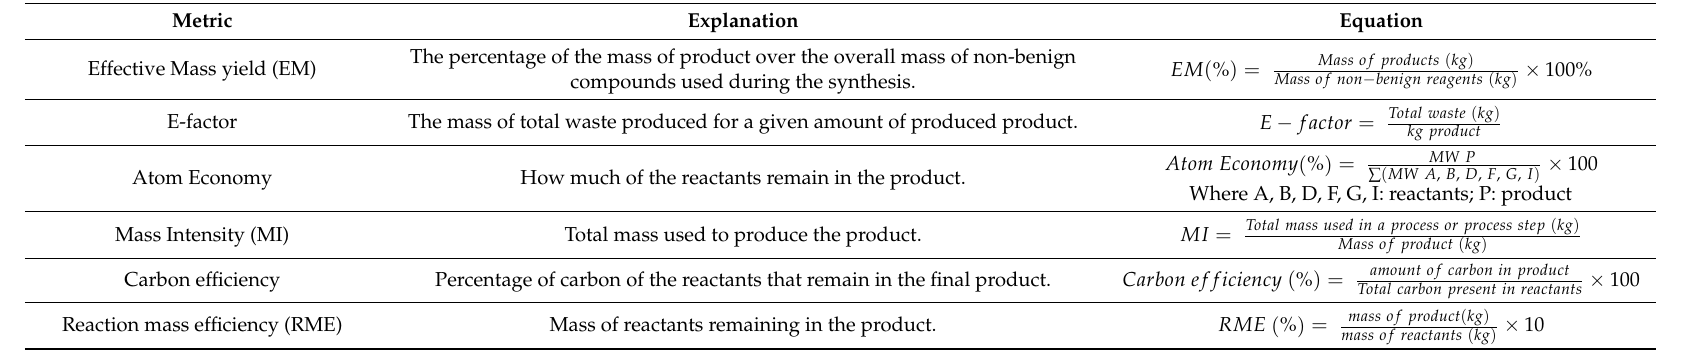
Table 2. List of metrics that have been proposed for “green” chemistry (reviewed by Constable et al. [38]).